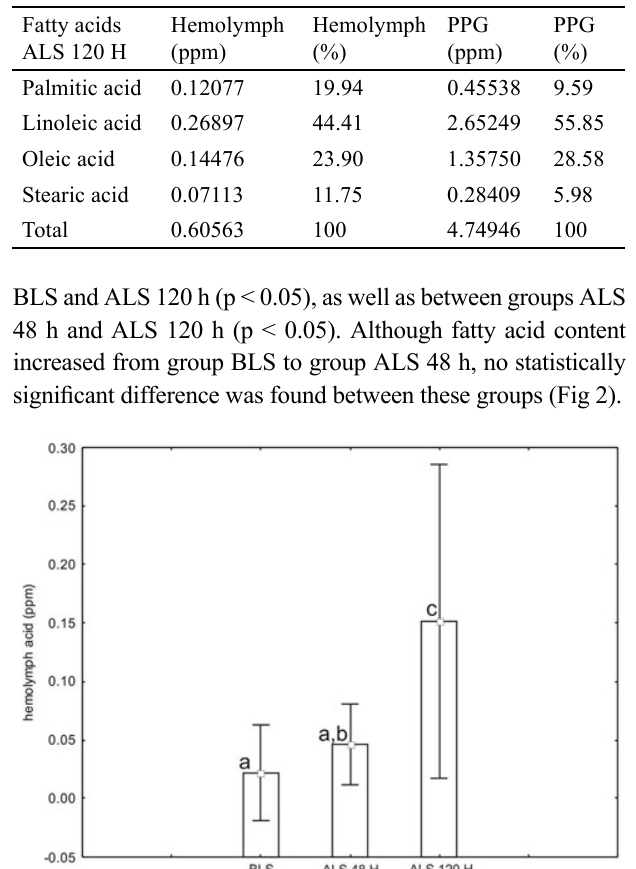
Table 3. Fatty acid quantification in the hemolymph and postpharyngeal glands (PPG) of Atta sexdens rubropilosa workers after lipid supplementation for 120 h (ALS 120 h).